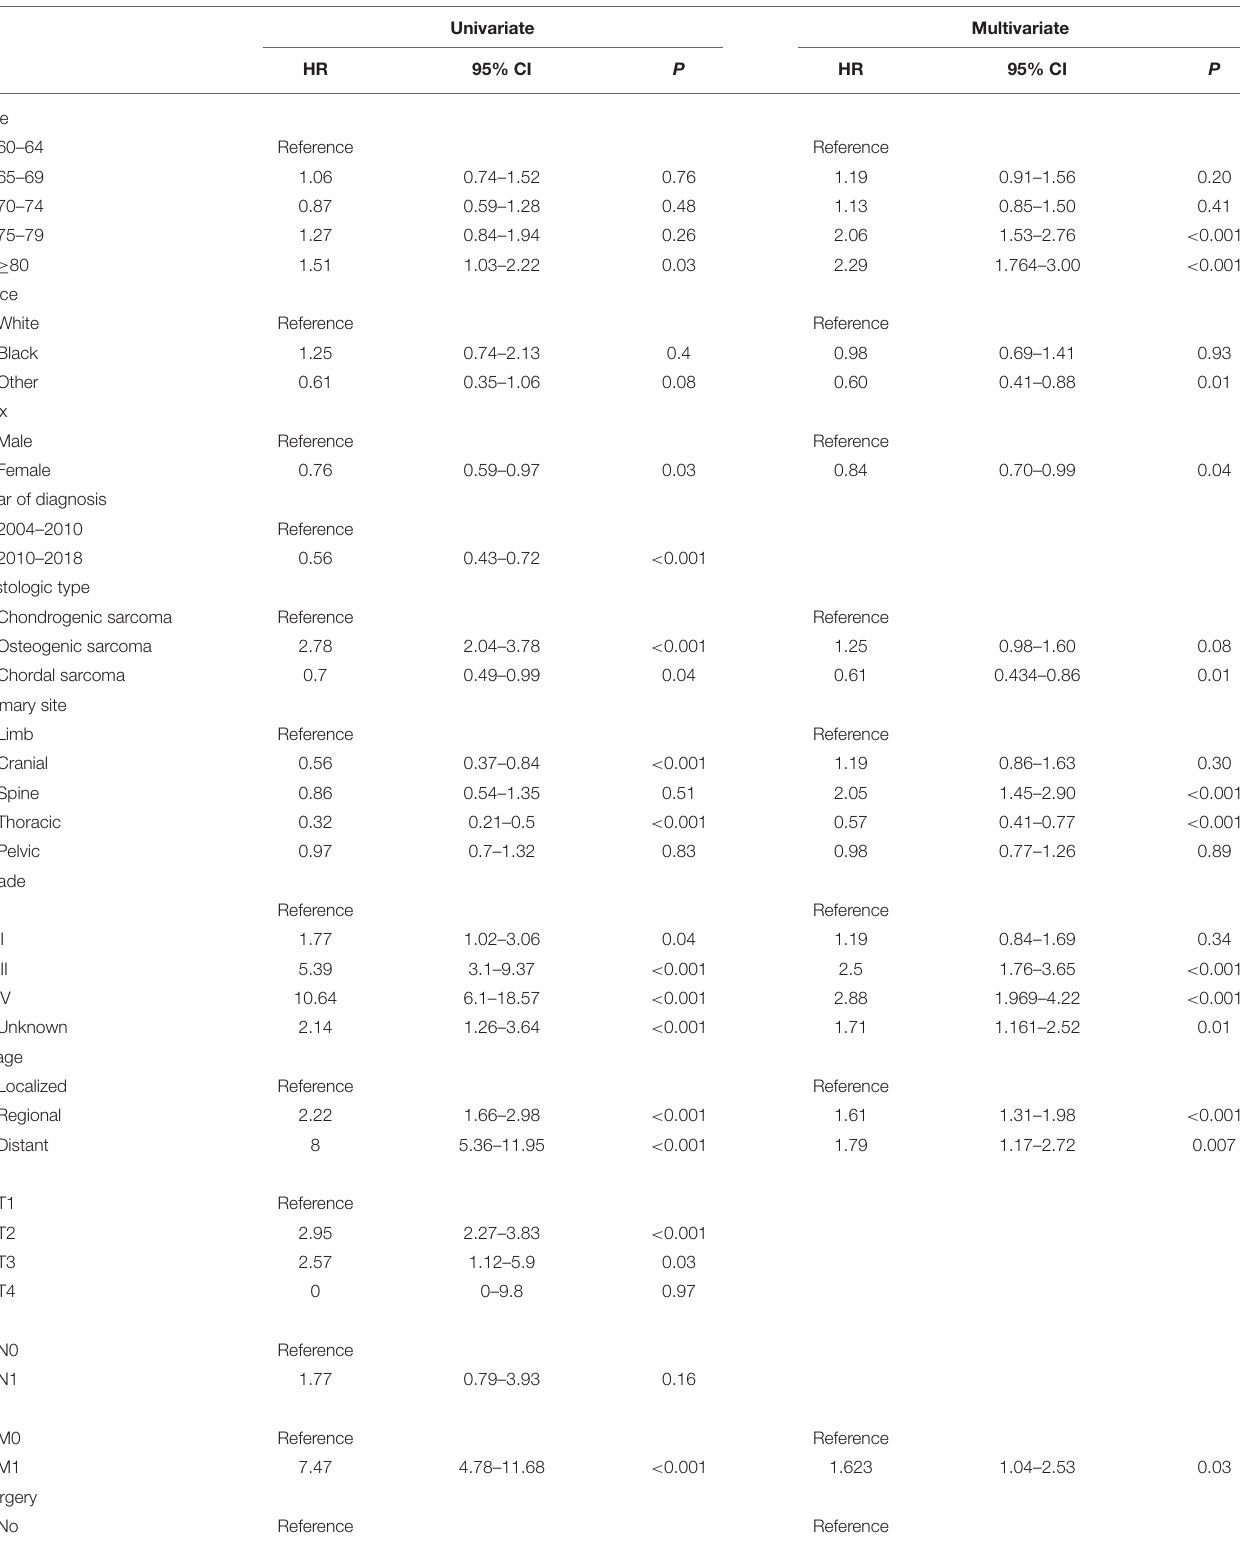
TABLE 2 | Univariate and multivariate analyses of OS in the training set. Univariate